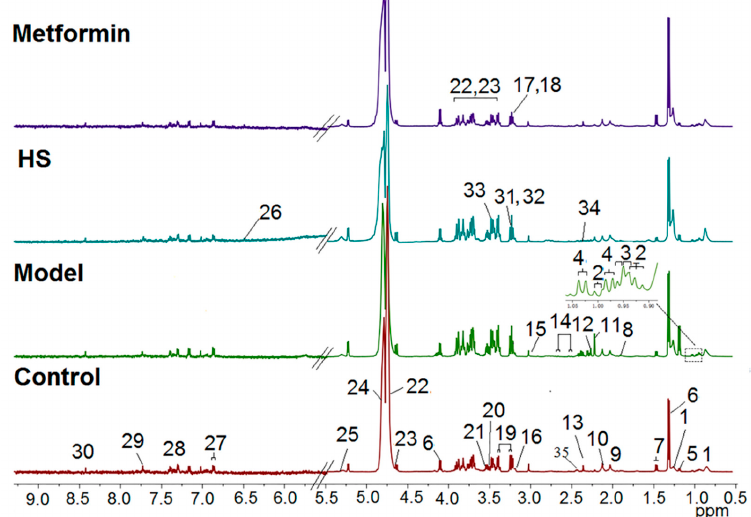
Figure 3. 1 H-NMR spectra of serum obtained from the 4 groups of rats. Keys: 1.lipid; 2. isoleucine; 3. leucine; 4. valine; 5. 3-hydrobutyrate; 6. lactate; 7. alanine; 8. acetate; 9. N -acetylglycoprotein; 10. methionine; 11. choline alfoscerate; 12. acetoacetate; 13. pyruvate; 14. citrate; 15. creatine; 16. choline; 17. phosphatidylcholine (PC); 18. glycerophosphocholine (GPC) ; 19. taurine; 20. glycine; 21. glycerol; 22. β -glucose; 23. α -glucose; 24. unsaturated lipid; 25. allantoin; 26. fumarate; 27. tyrosine; 28. phenylalanine; 29. xanthine; 30. formate; 31. Trimethylamine N -oxide (TMAO); 32. betaine; 33. threonine; 34. succinate 35. glutamine.